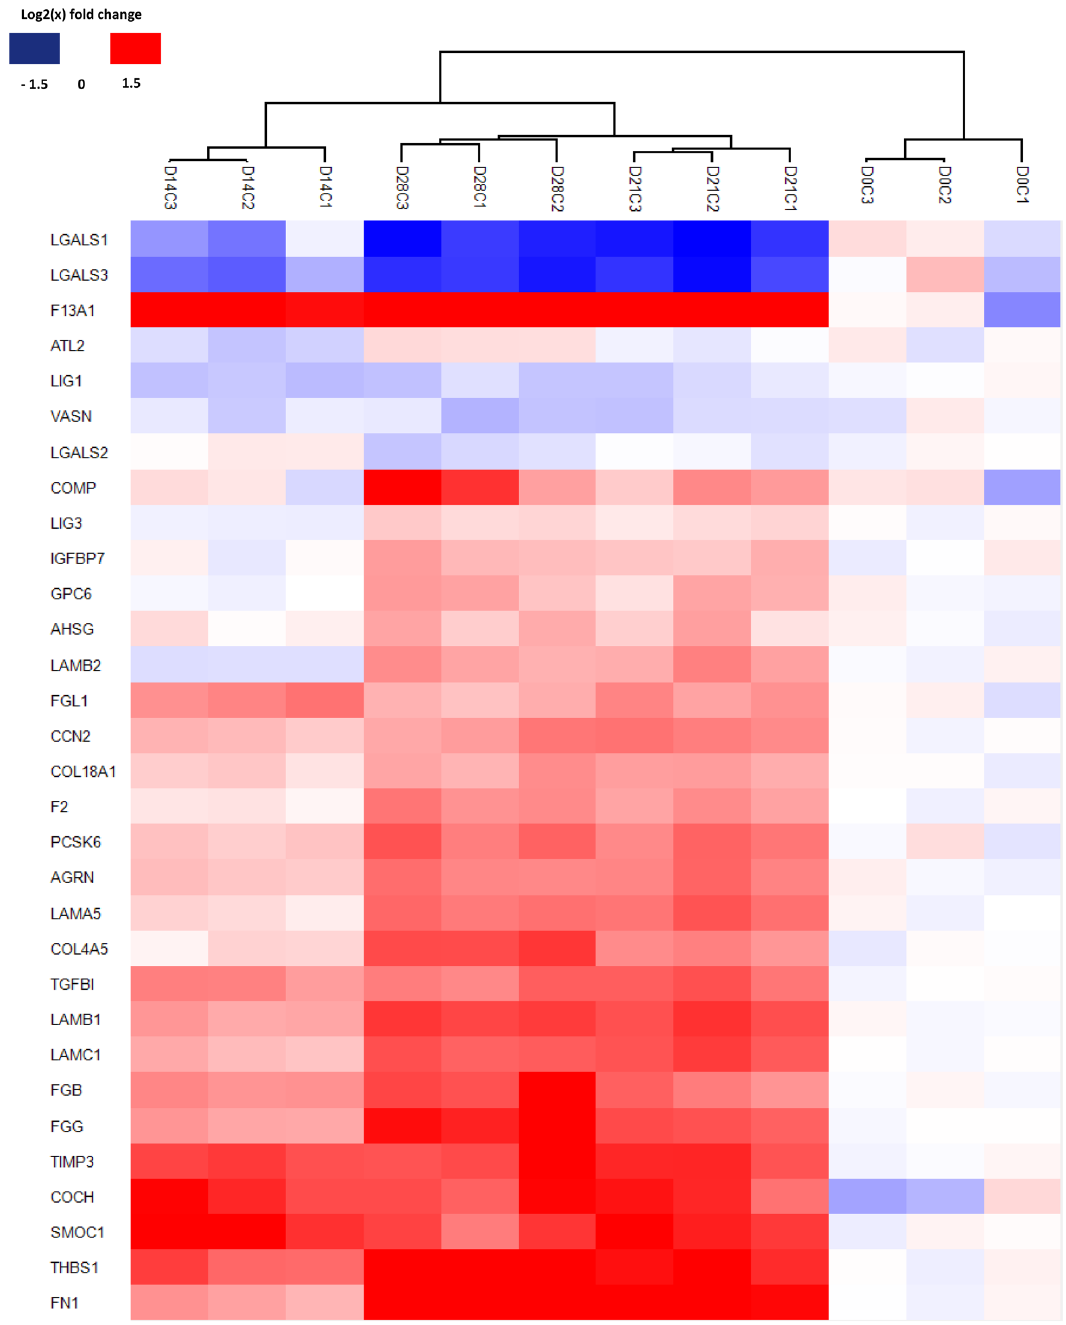
Figure 5. Hierarchical clustering of proteins involved in the ECM. Figure generated using Perseus v. 1.6.7.0 software 28